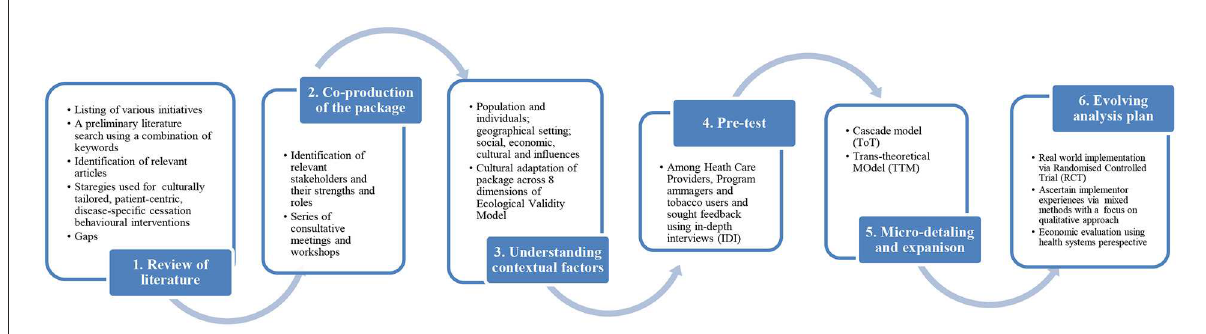
FIGURE1 Flow of intervention package development process with major steps.